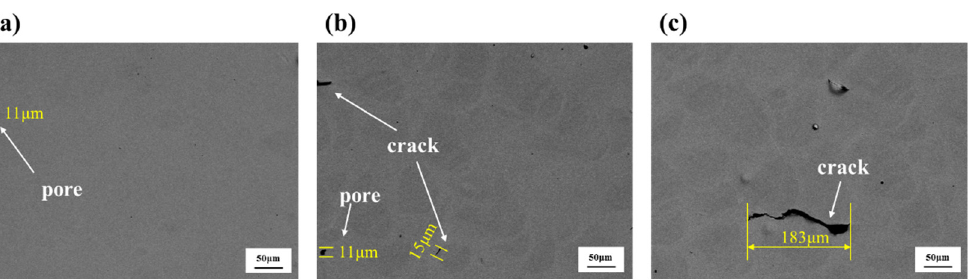
Figure 4. SEM images of defects in SLM-fabricated composites with three different scanning speeds: ( a ) 650 mm/s, ( b ) 800 mm/s, ( c ) 1000 mm/s.